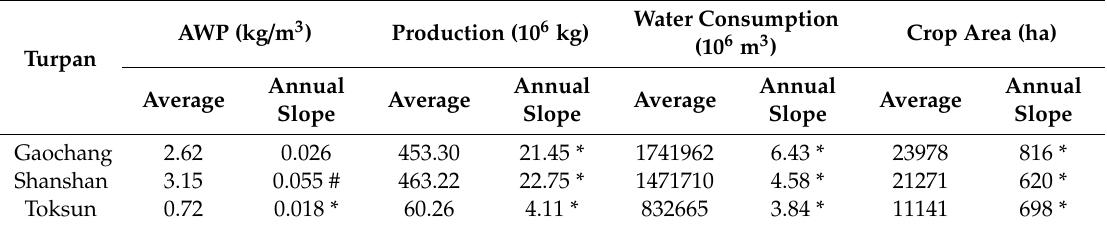
Table 1. Average values and annual change rates in AWP, production, water consumption and crop area in the counties and district of Turpan during 2002–2015.